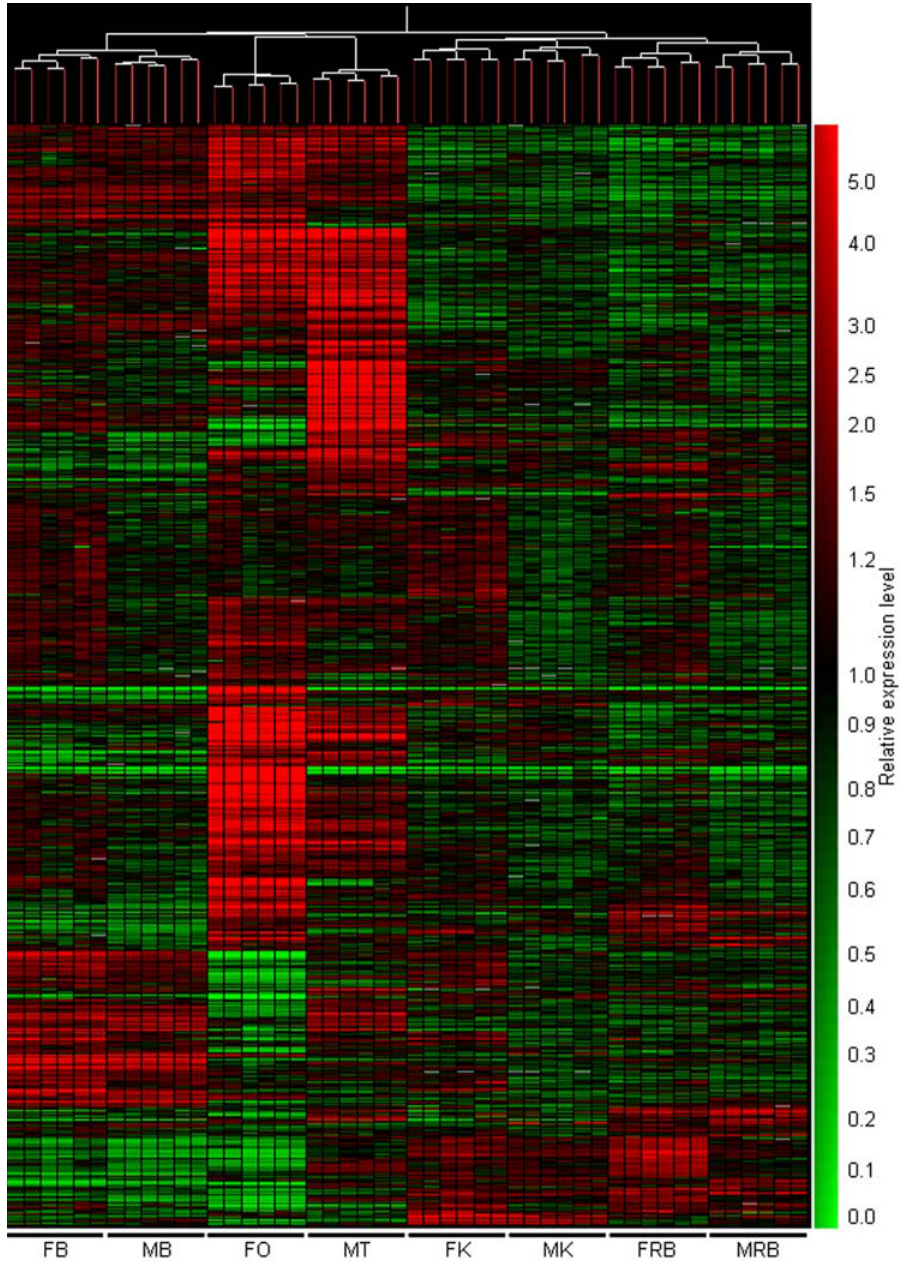
Figure 4. Hierarchical clustering of expression profiles for 6331 genes across eight different organs. Individual gene expression profiles are plotted horizontally against vertical columns of organ type. For each organ, profiles for the three biological replicates and each of their two technical replicates are displayed. Strongly expressed and weakly expressed genes with respect to the common reference are represented in red and green respectively. All organs showed a high level of correlation between biological and technical replicates. The gonads contained the highest number of strongly expressed transcripts. Many genes showed sexually dimorphic gene expression in the gonads and in other organs. Clustering showed correlation between expression profiles of different organs. Kidney targets clustered together with ‘rest-of-body’, while ovary and testis clustered with brain targets to form a distinct group. Refer to Fig. 2 for abbreviations.